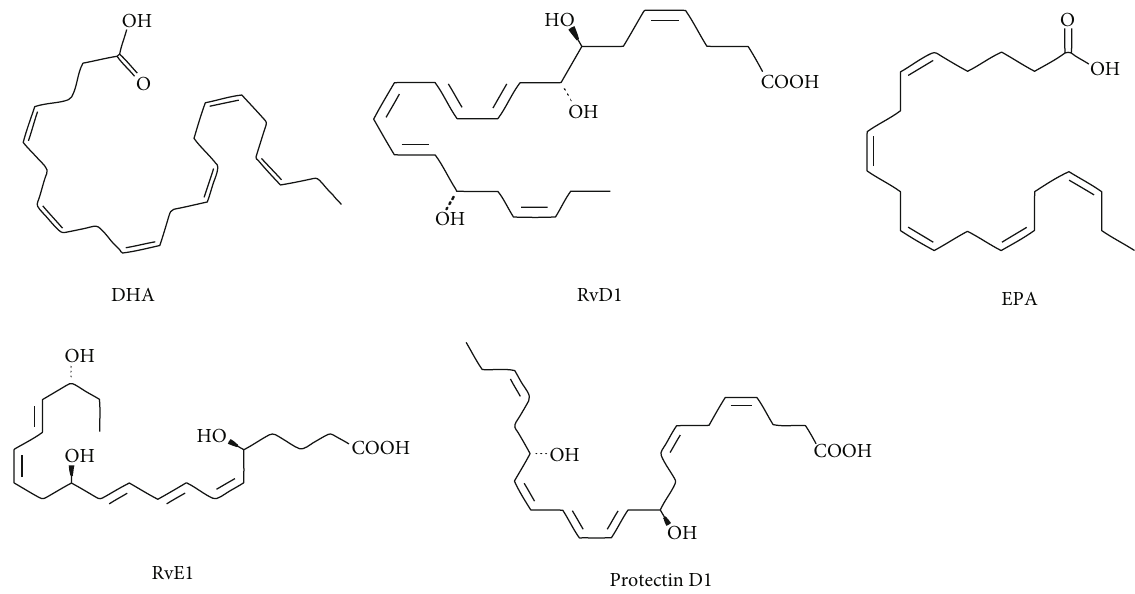
Figure 2: Structure of metabolites. DHA: docosahexaenoic acid; RvD1: resolvin D1; EPA: eicosapentaenoic acid; RvE1: resolvin E1. Citation: